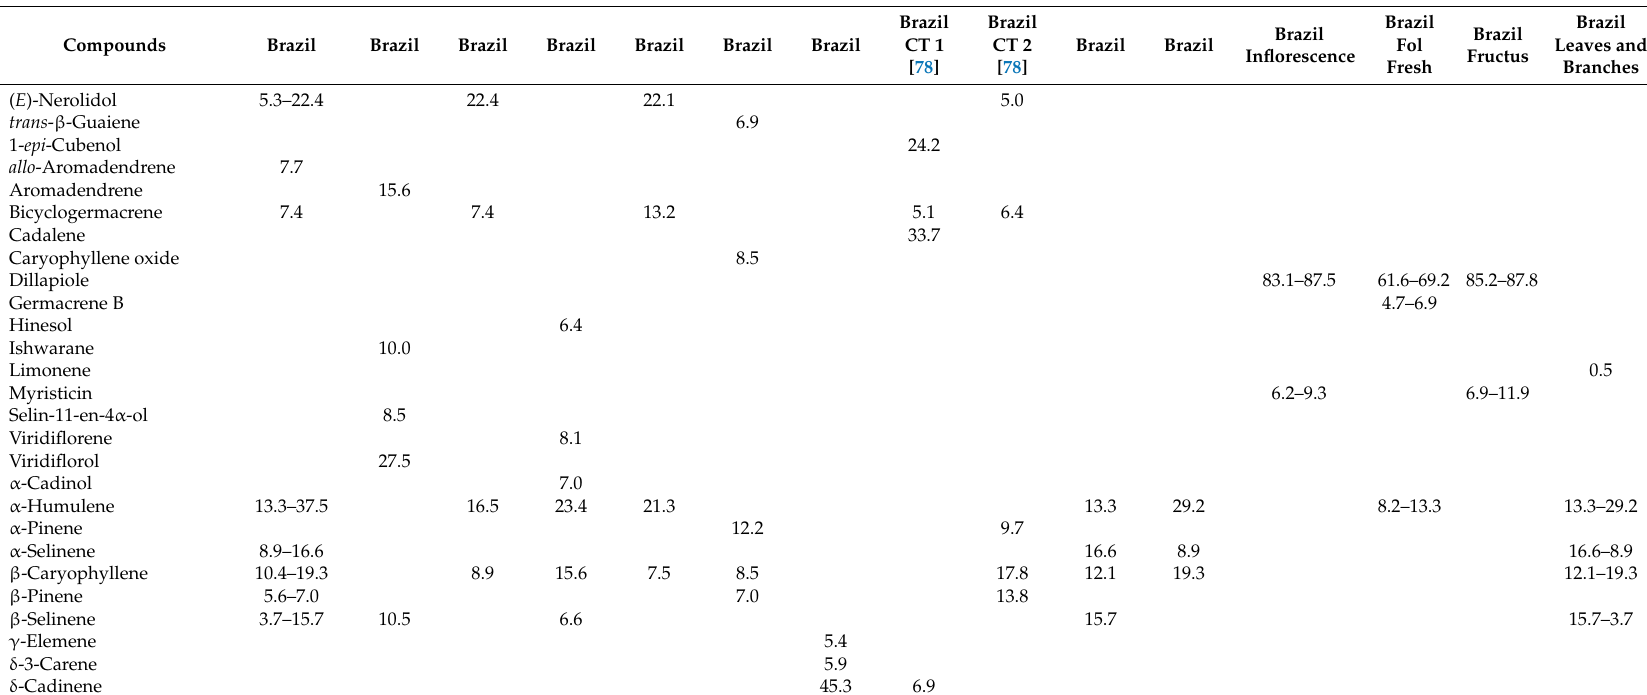
Table 17. Chemical compositions (%) of Piper gaudichaudianum Kunth essential oils.